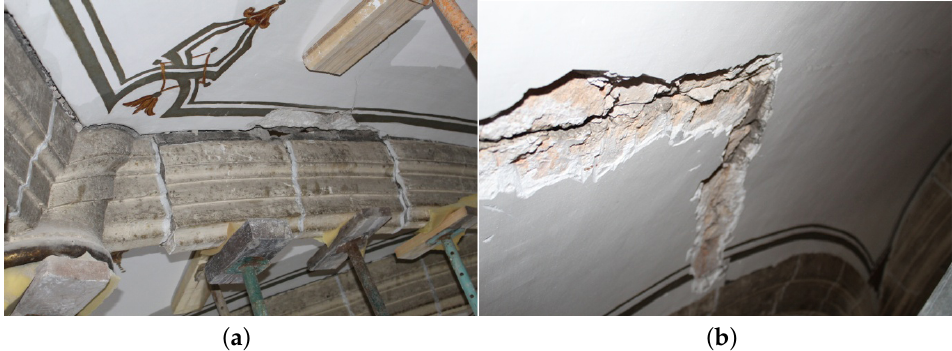
Figure 15. ( a ): Downturned voussoirs of diagonal arches. ( b ): Deformations and cracks in vaults. Nor has any differential movement been observed in the arch supports where they meet the perimeter